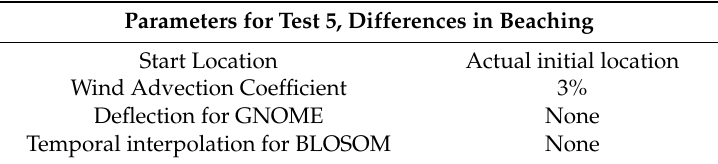
Table 8. Parameters for test 5, differences in